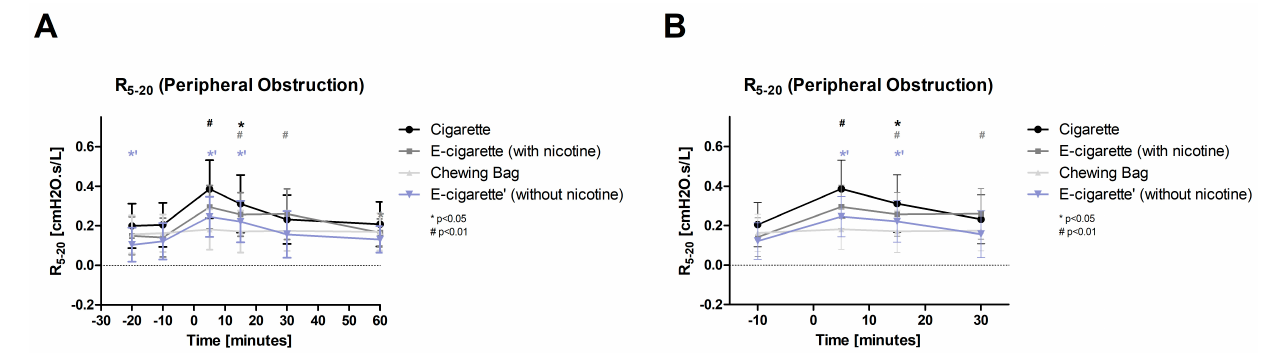
Figure 8. R5 (Central obstruction: ( A ) total follow-up; ( B ) follow-up of expected nicotine half-life). The central obstruction is displayed over time. The first (time 5) and second (time 15) measurements after the intervention Cig, E-Cig (+) and E-Cig (-) show a significant (* p < 0.05) increase. The Chewing bag stays at resting levels.